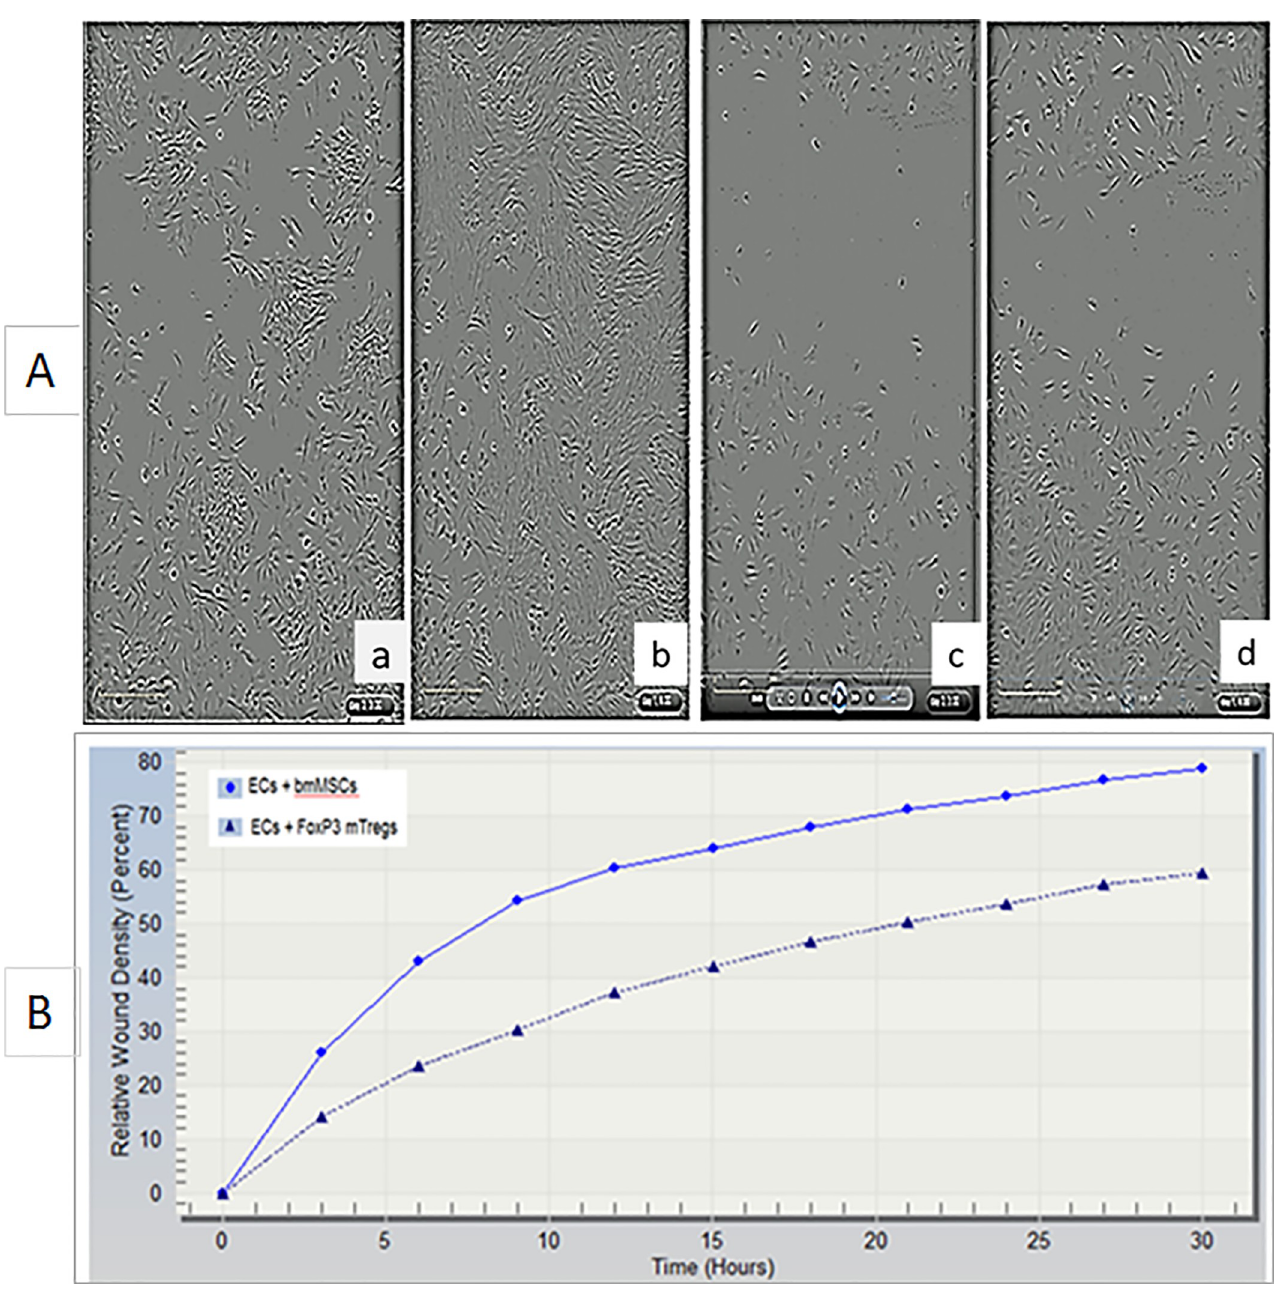
Fig 3. FoxP3+ mTregs inhibits cell migration, invasion and relative wound density (RWD) in injured human endothelial cells (ECs). ECs were treated with MSCs [3A (a, start 3hrs; b, end 30hrs)] or FoxP3+ mTregs [3A (c, start 3hrs; d, end 30hrs)]. FoxP3+ mTregs inhibit RWD in injured human ECs (3B) and S1